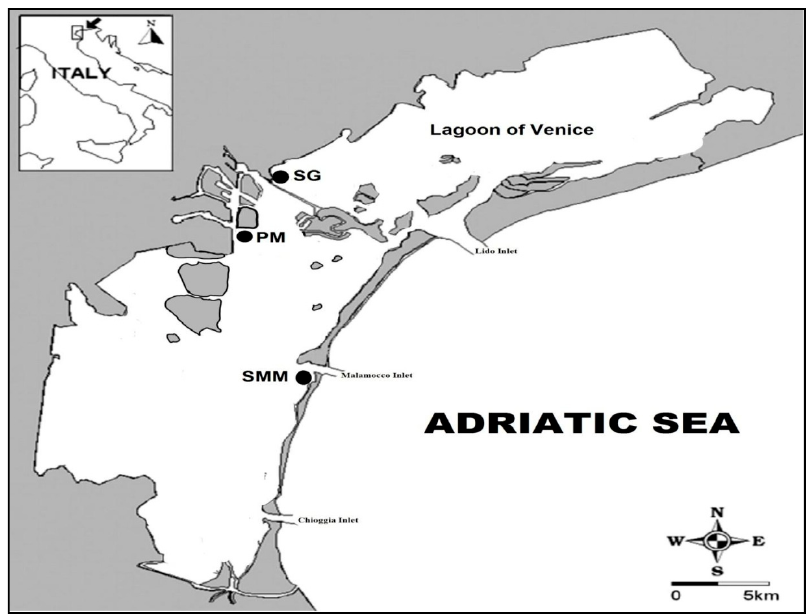
Figure 1. Map of the sampling sites across the central basin of the Lagoon of Venice (Italy). SMM: Santa Maria del Mare, PM: Porto Marghera, and SG: San Giuliano.